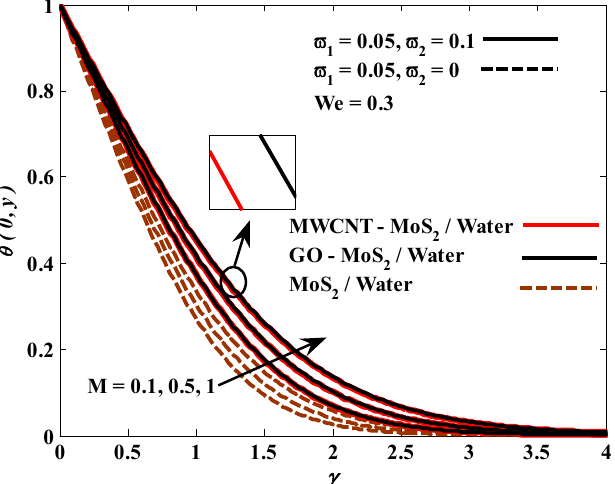
Figure 9. The behavior of hybrid nanofluid’s temperature under the effect of M.